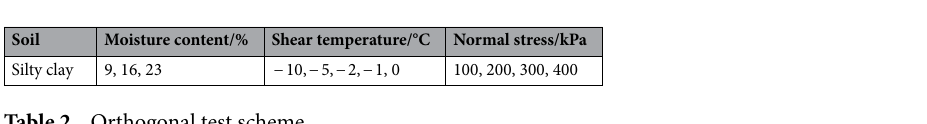
Table 2. Orthogonal test